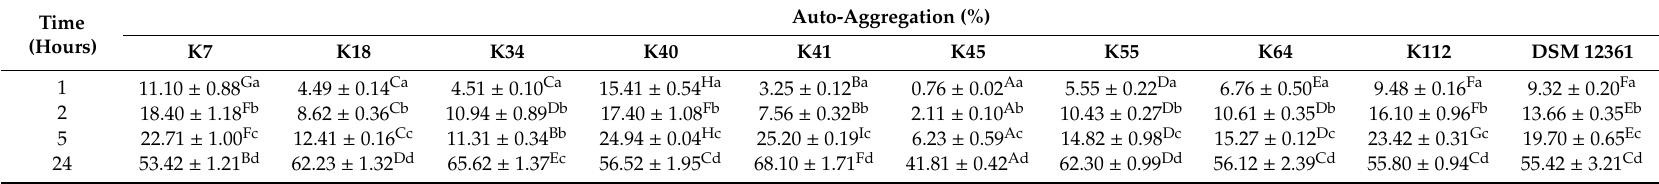
Figure 3. Adhesion of the L. kunkeei strains to toluene and xylene (expressed as hydrophobicity %) measured using bacterial ability to adhere to hydrocarbons (BATH) test after different contact times (CTs). A : 15 min; B : 30 min; C : 60 min. Table 1. Auto-aggregation (%) of the L. kunkeei strains after 1, 2, 5, and 24 h of incubation at 37 °C. Results are shown as mean ± standard deviation (n = 3). Different lowercase letters (a-d) indicate significant differences by column, and different uppercase letters (A-I) in each row indicate significant differences by row ( p < 0.05).